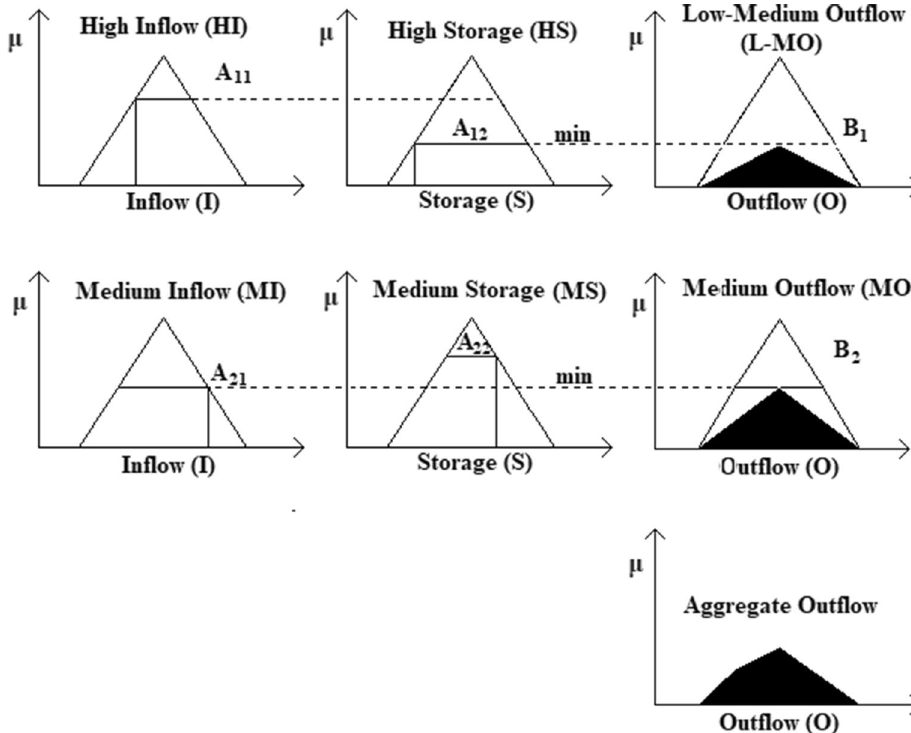
Fig. 6 Graphical Mamdani (max-product) implication